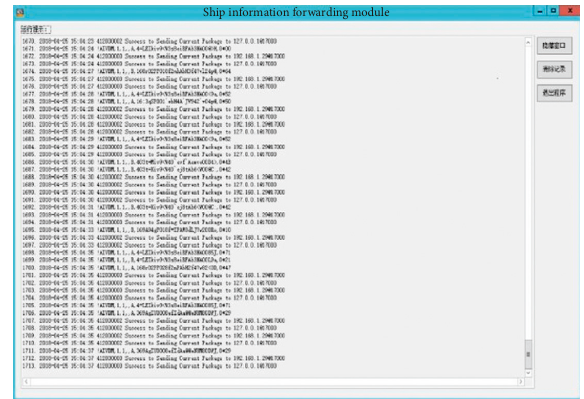
Figure 12: Data acquisition and forwarding software interface.